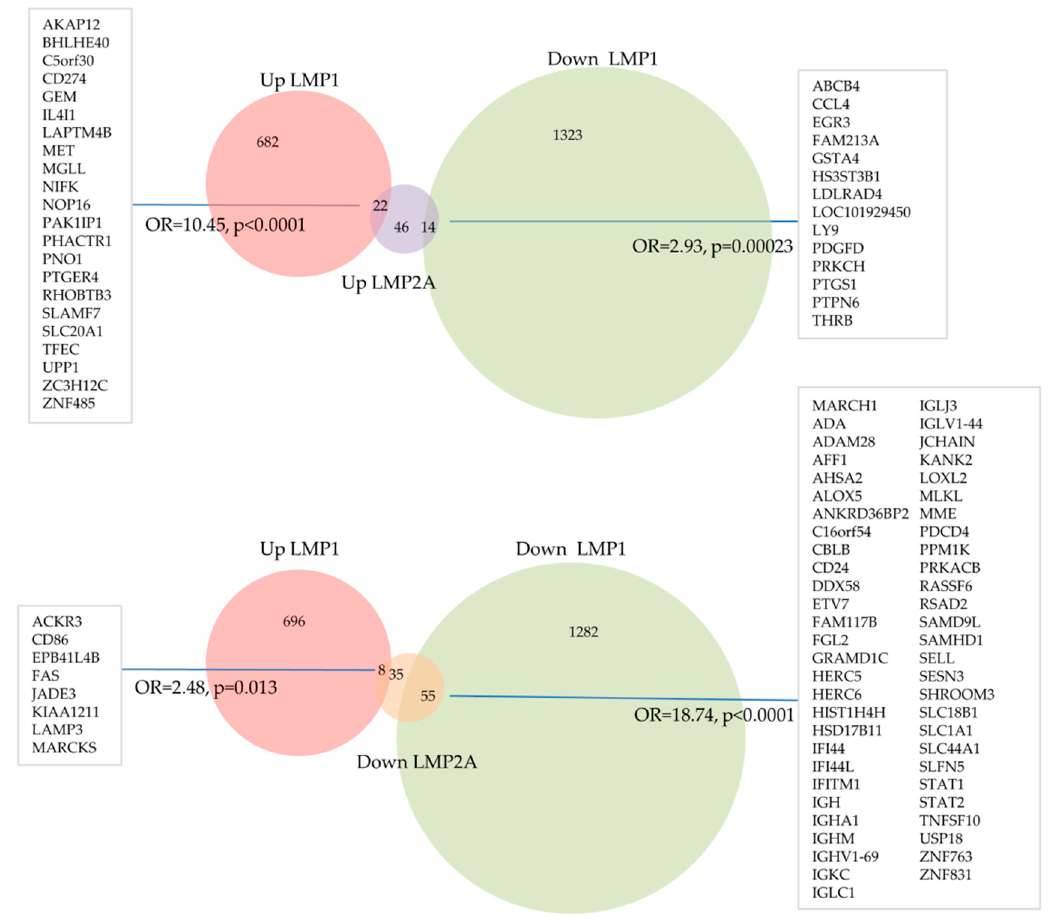
Figure 2. Overlap between LMP1- and LMP2A-regulated genes in primary human GC B cells. Genes differentially expressed following transfection of normal GC B cells with either LMP1 or LMP2A identified in our reanalysis of existing published data. Statistical significance of overlap between gene sets was determined using Chi-square test.